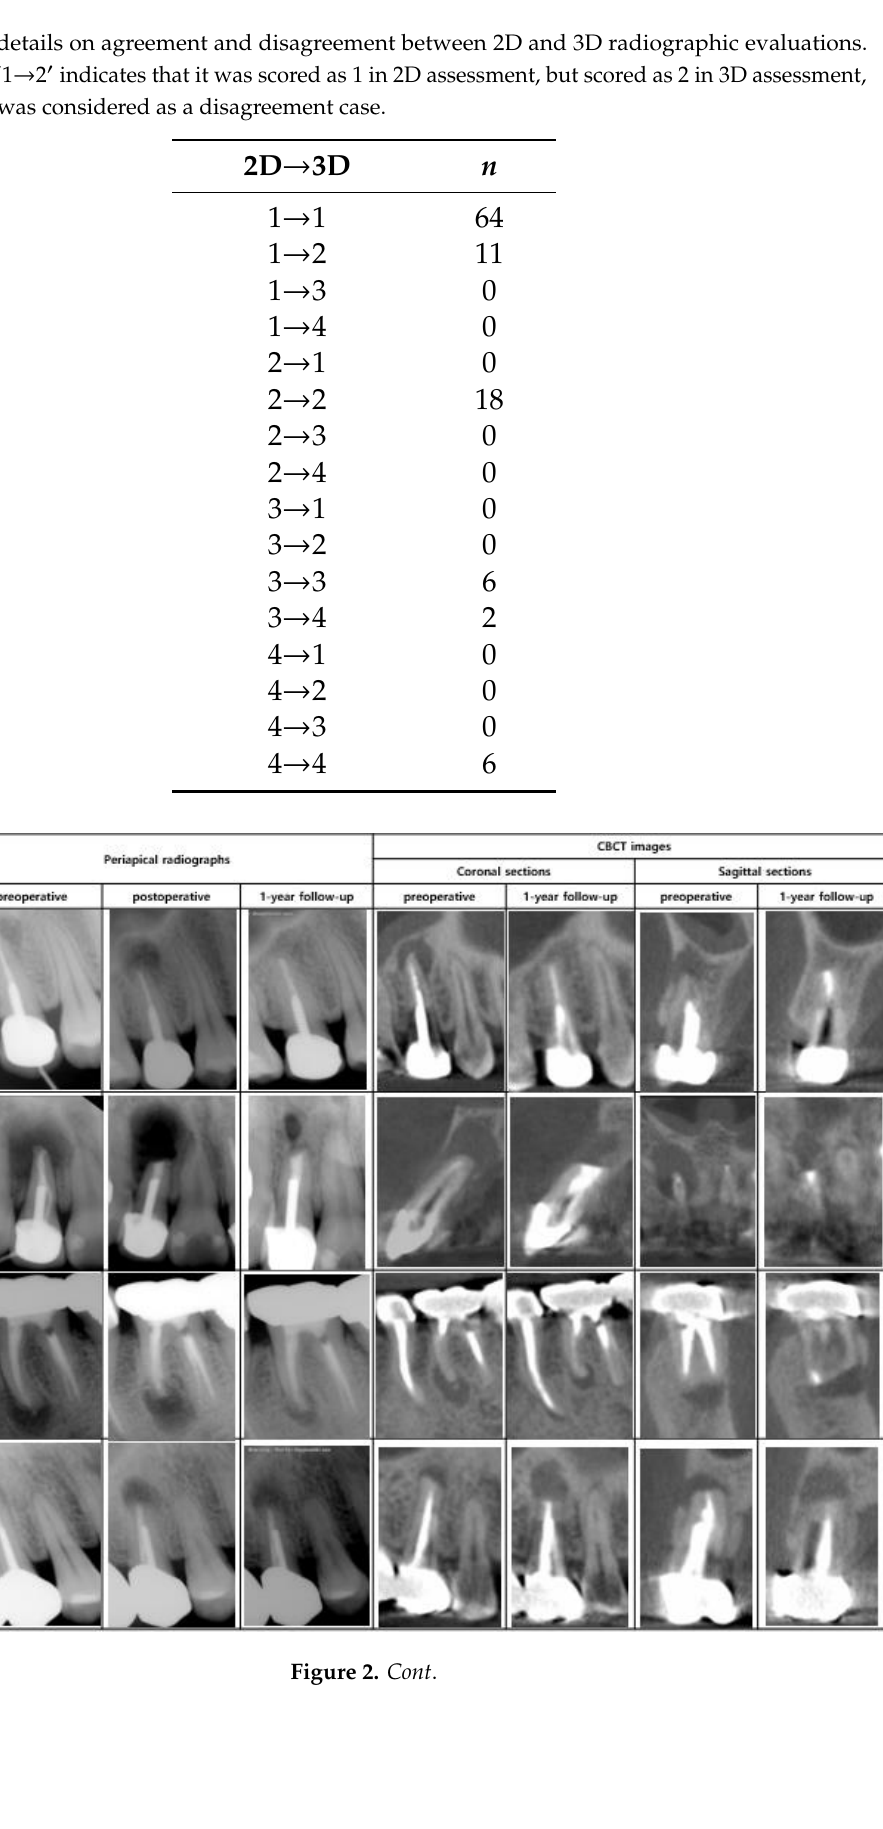
Figure 2. ( A ) Examples of agreement cases. The images in each row were scored 1, 2, 3 and 4 resulted from both 2D and 3D assessments. ( B ) Examples of disagreement cases. The images at the first row were scored 1 from 2D assessment, but scored 2 from 3D assessment. The images at the second row were scored 3 from 2D assessment, but 4 from 3D assessment. 4. Discussion Molven’s and Rud’s criteria have been predominant methods for evaluating periapical radiographic healing outcomes of endodontic microsurgery. However, the evaluation using periapical radiographs was limited to the mesiodistal plane of the tooth, which could provide little information on periapical lesion. With CBCT, periapical lesions and teeth can be evaluated buccolingually as well as mesiodistally, which could provide more data on the tooth and the lesion. In this regard, preoperative CBCT is required to estimate and predict the process before endodontic surgery. A study found that using Rud’s criteria at the one-year follow-up may be acceptable to